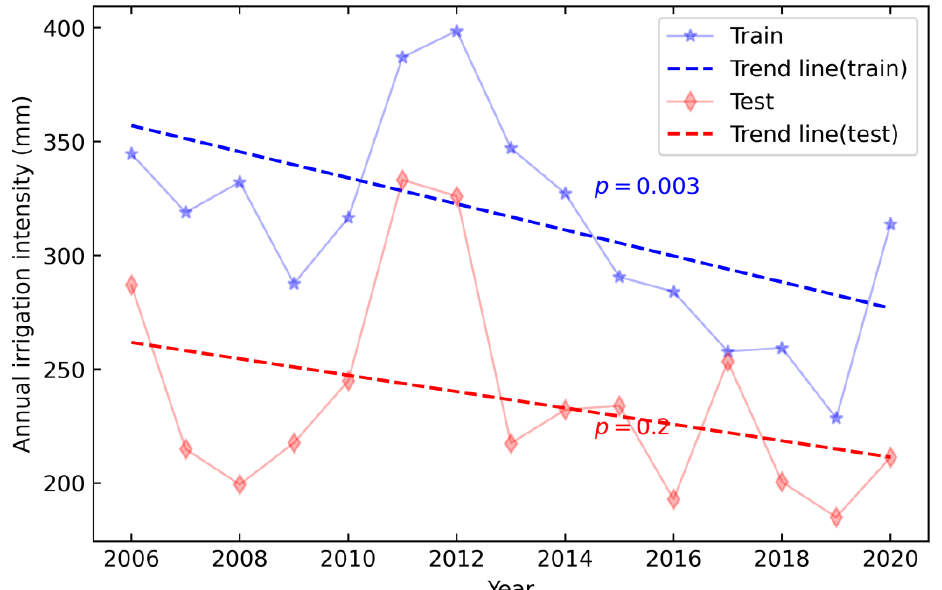
Figure 8. Spatially averaged annual irrigation intensity calculated for the training and test portions